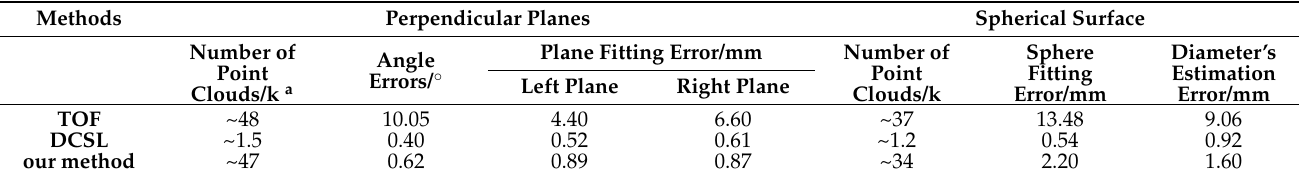
Table 2. Reconstructed results of TOF, DCSL and the proposed